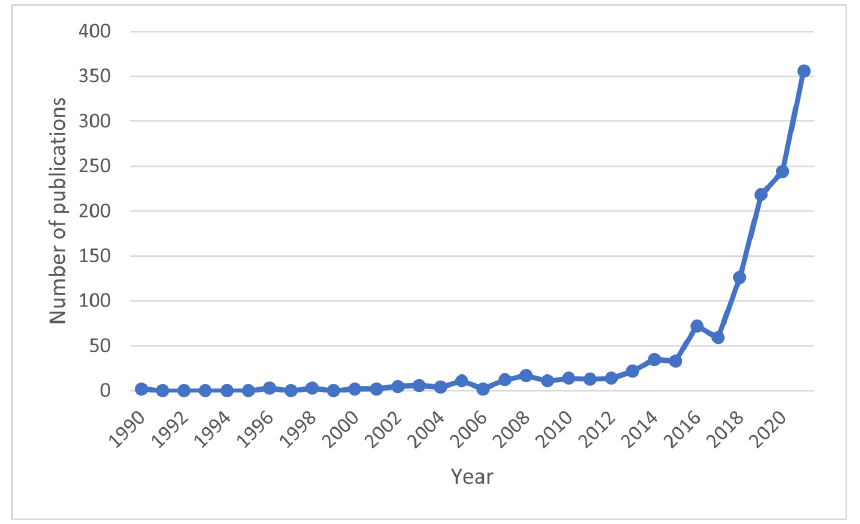
Figure 6. Evolution of Scopus-indexed articles for last-mile